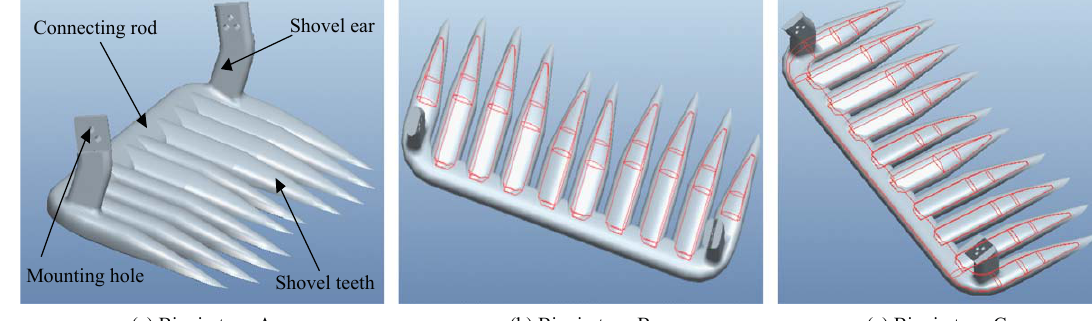
Fig. 7. Design three-dimensional model of the